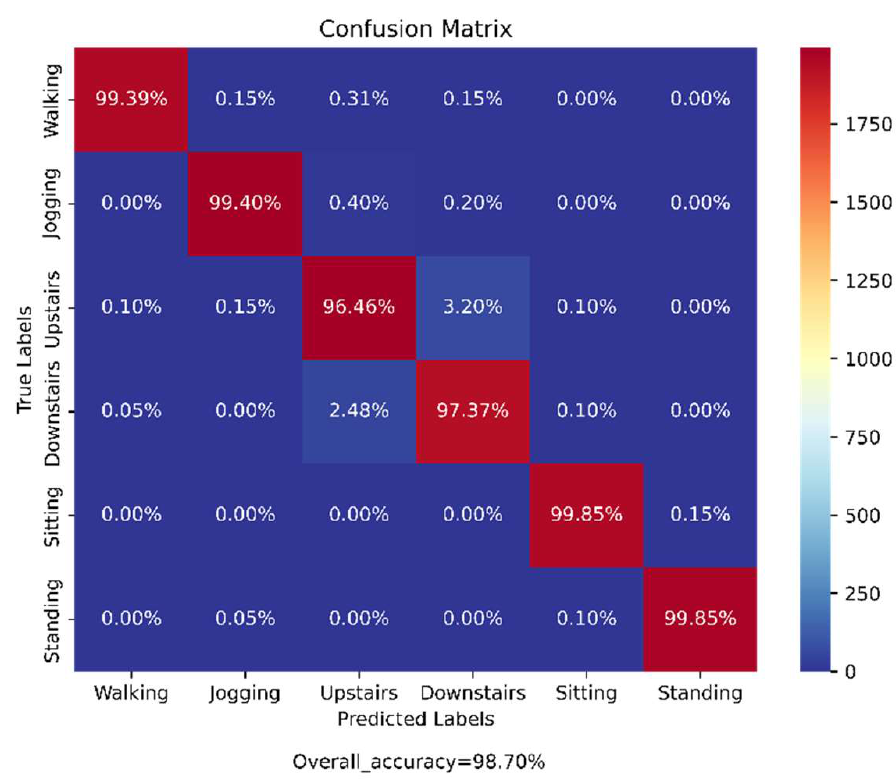
Figure 10. Confusion matrix from the evaluation of our proposed Ensem-HAR model on the WISDM dataset.